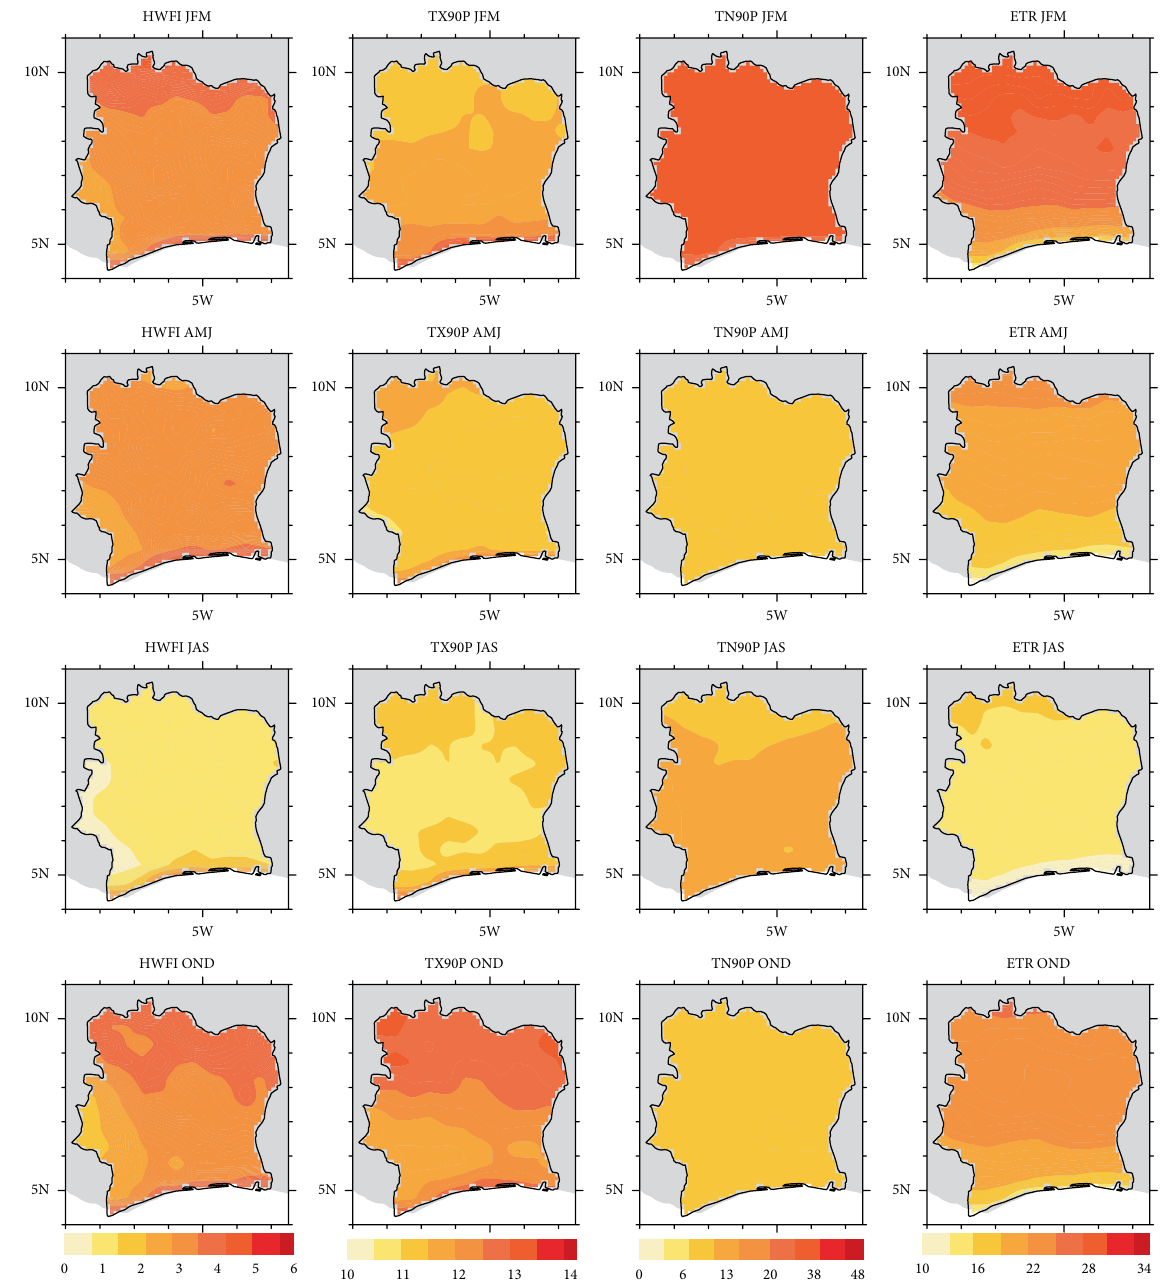
Figure 3: Seasonal distribution of the different extreme temperature indices (HWFI, TX90P, TN90P, ETR) in Côte d’Ivoire during the 1976–2005